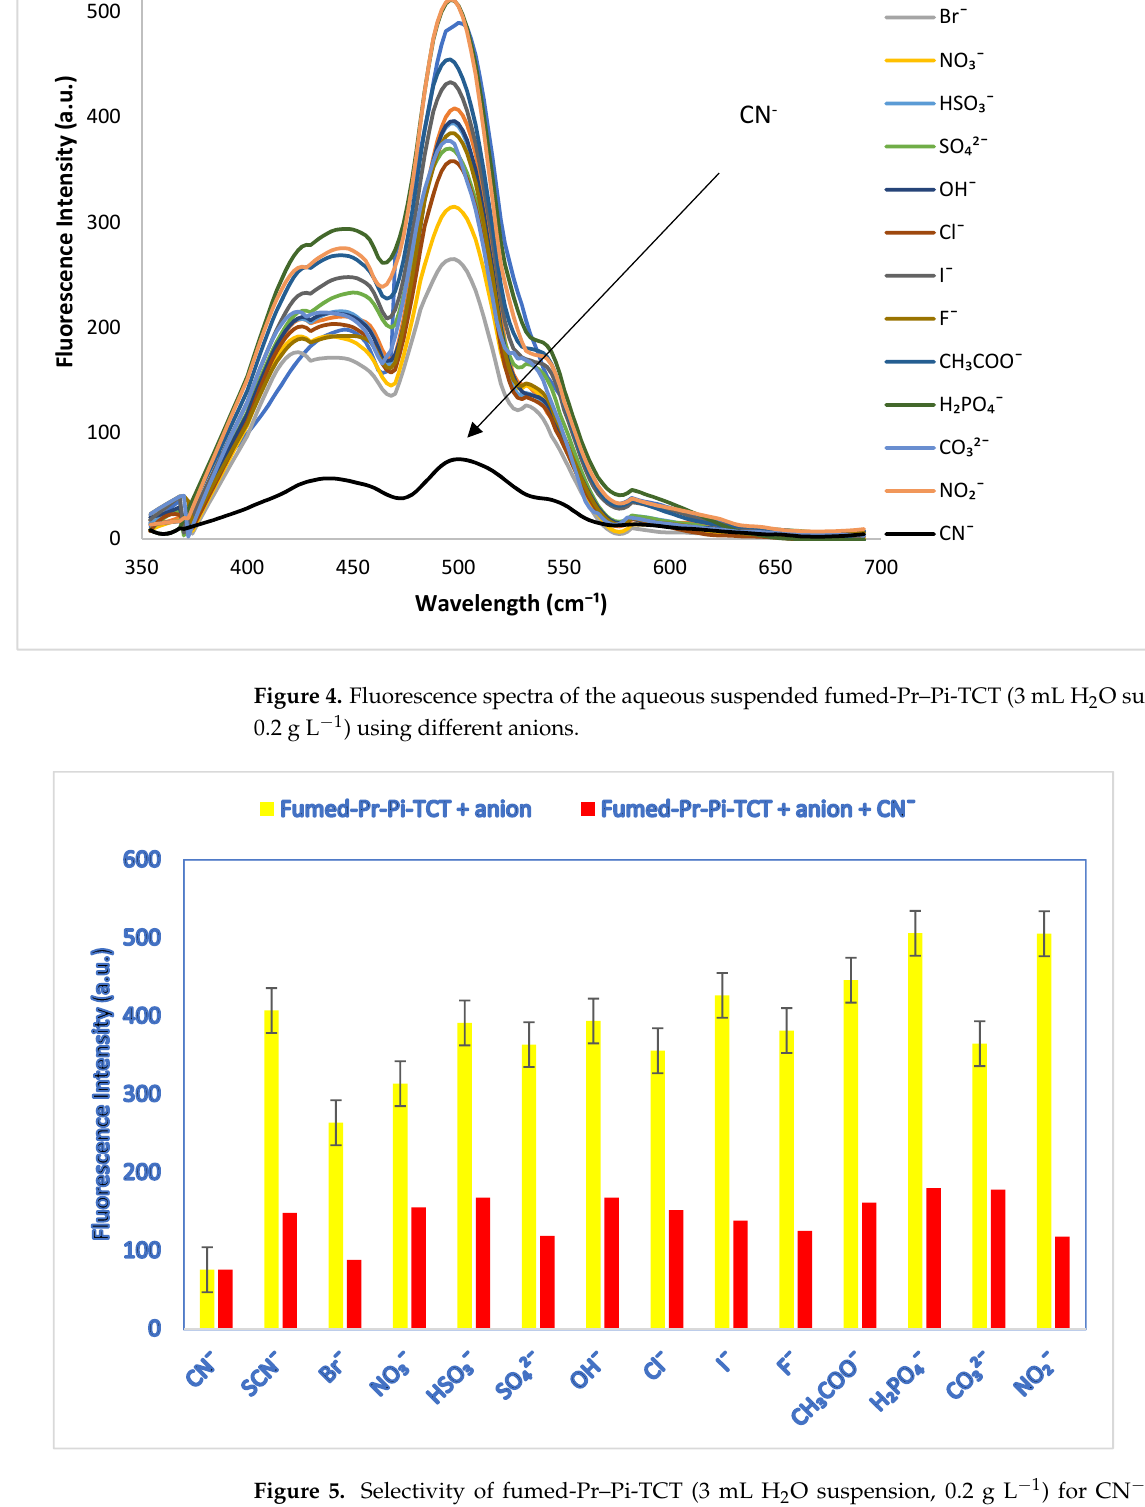
Figure 6. Fluorescence response of fumed-Pr-Pi-TCT (3 mL H ₂ O suspension, 0.2 g L − 1 ) after adding different concentrations of CN − .